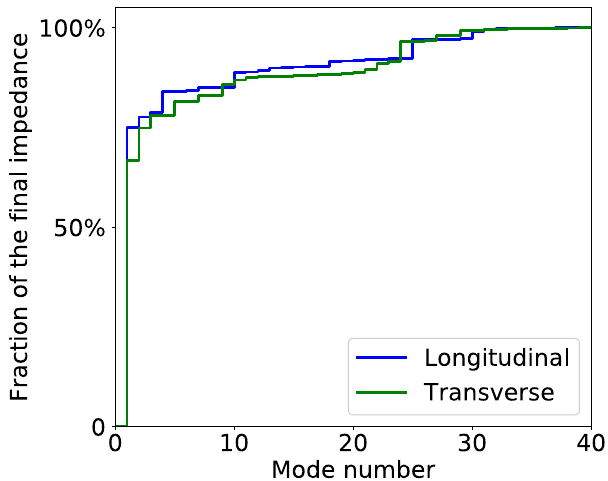
FIG. 11. Convergence check for the FCC-hh beam screen with the slit width 7.5